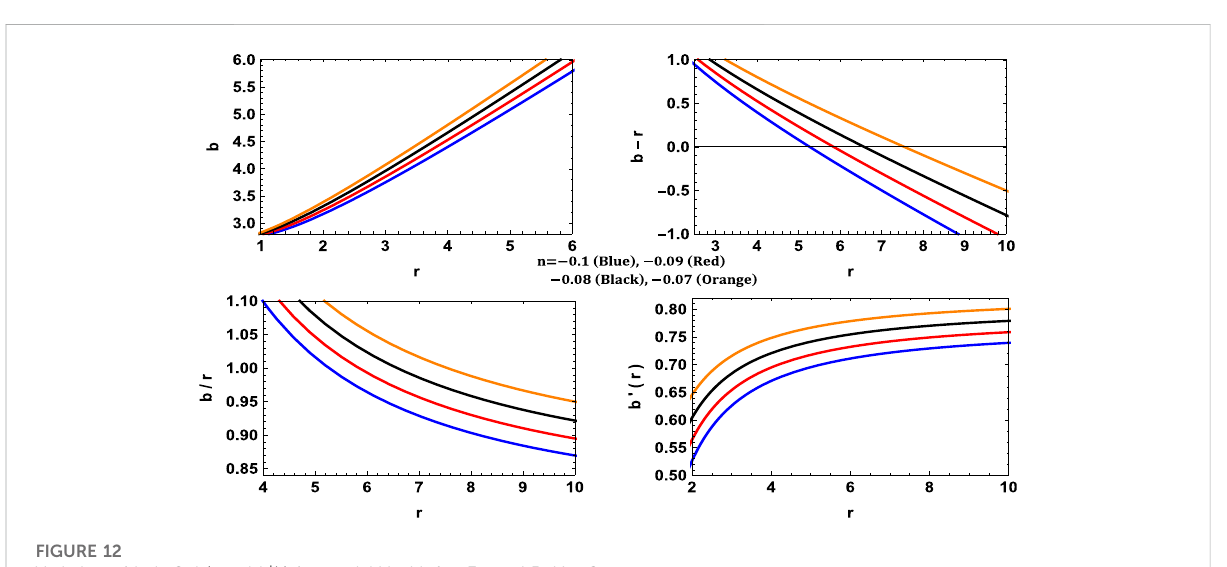
FIGURE 12 Variation of b , b − 2, b / r and b ′ ( r ) for model V with λ = 3, γ = 1.5, M = 2.